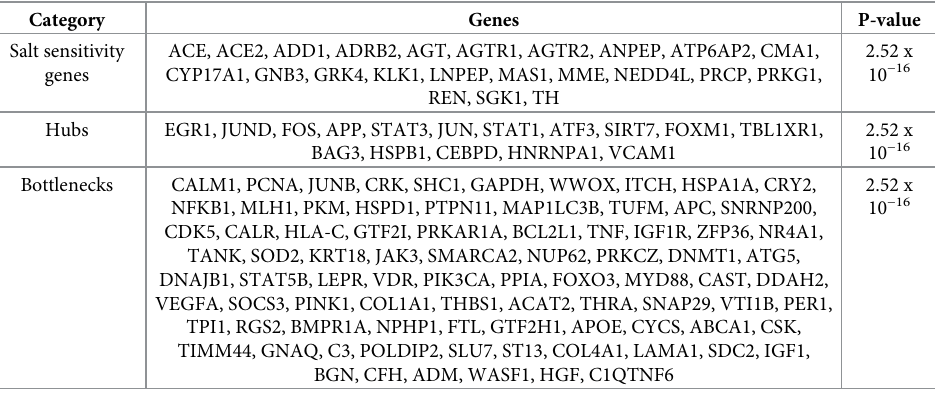
Table 3. The genes involved in obesity categorized as hubs, bottlenecks and salt sensitivity